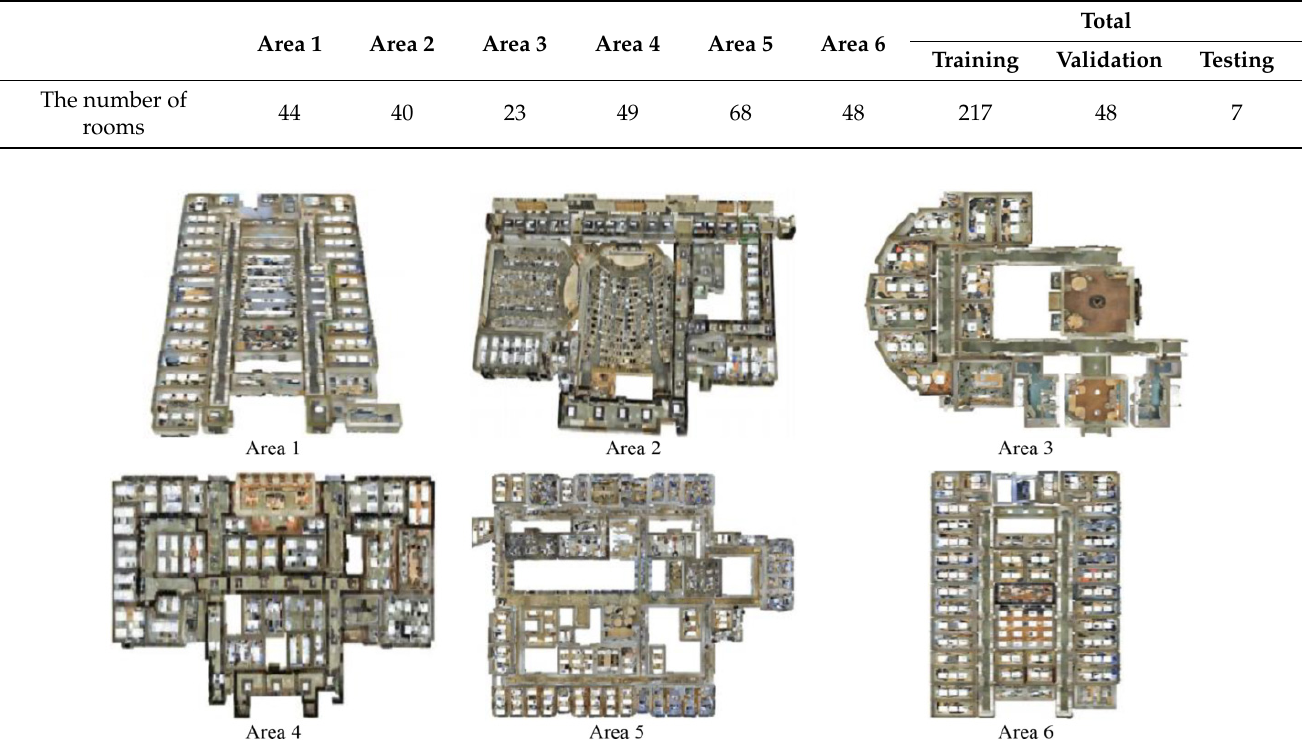
Figure 7. The S3DIS dataset contains thumbnails of Area 1 to Area 6.